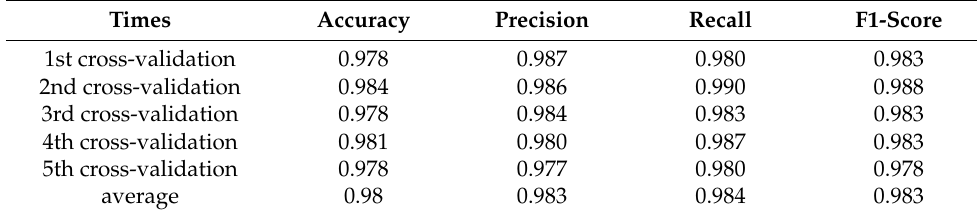
Table 3. Performance of multi-classifiers in IoT device identification on